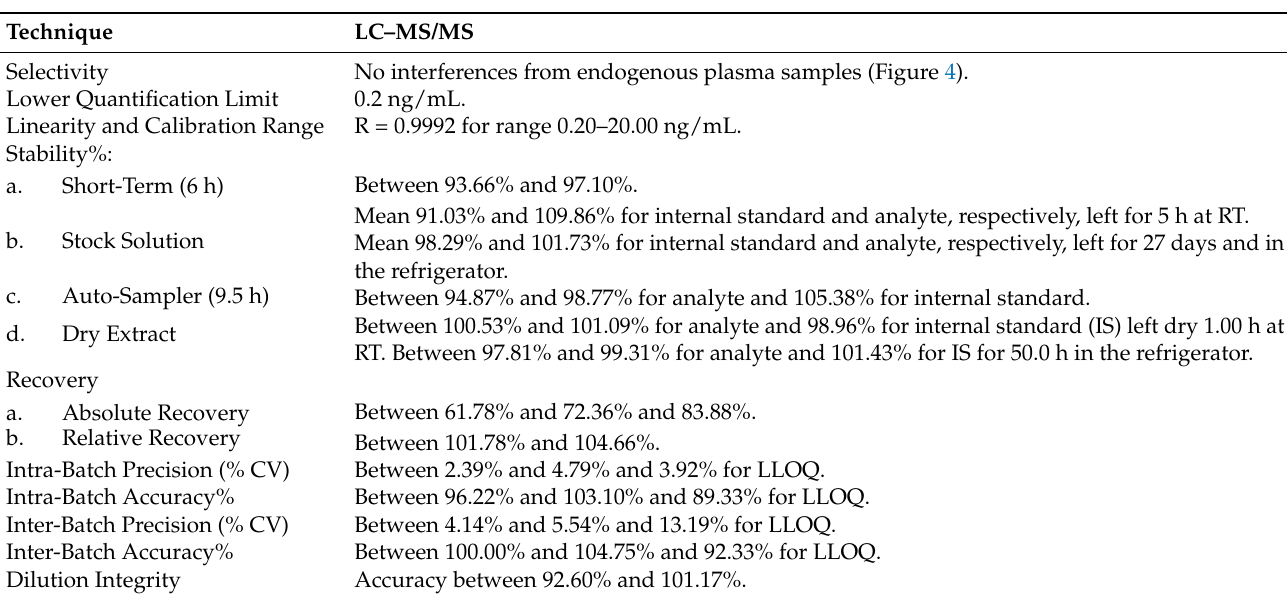
Table 11. Characteristics outcome of the validated method carried.